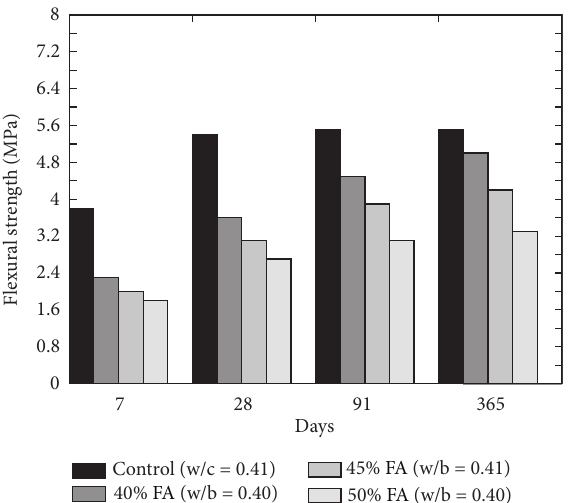
Figure 19: Effect of increasing FA content on the elastic modulus of concrete